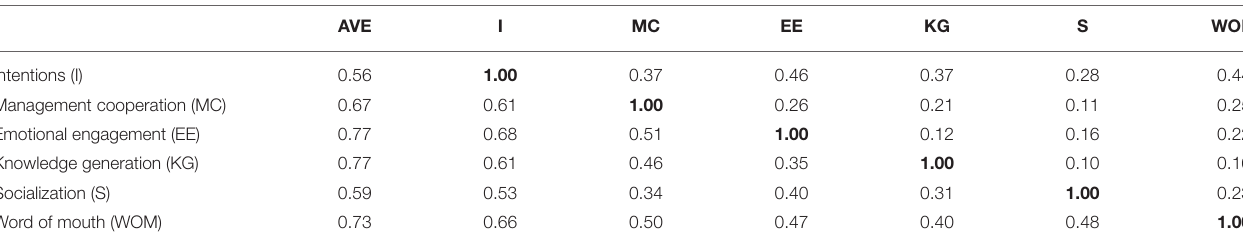
TABLE 4 | Correlation matrix